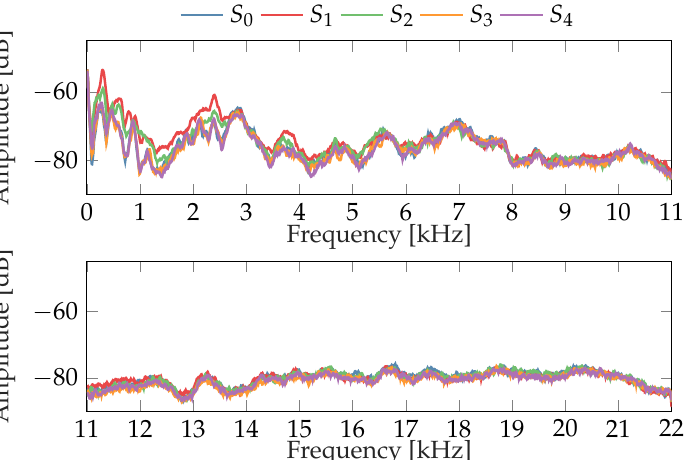
Figure 12. Averaged frequency spectra of the measurement series of the gearbox with damage to gear z 3